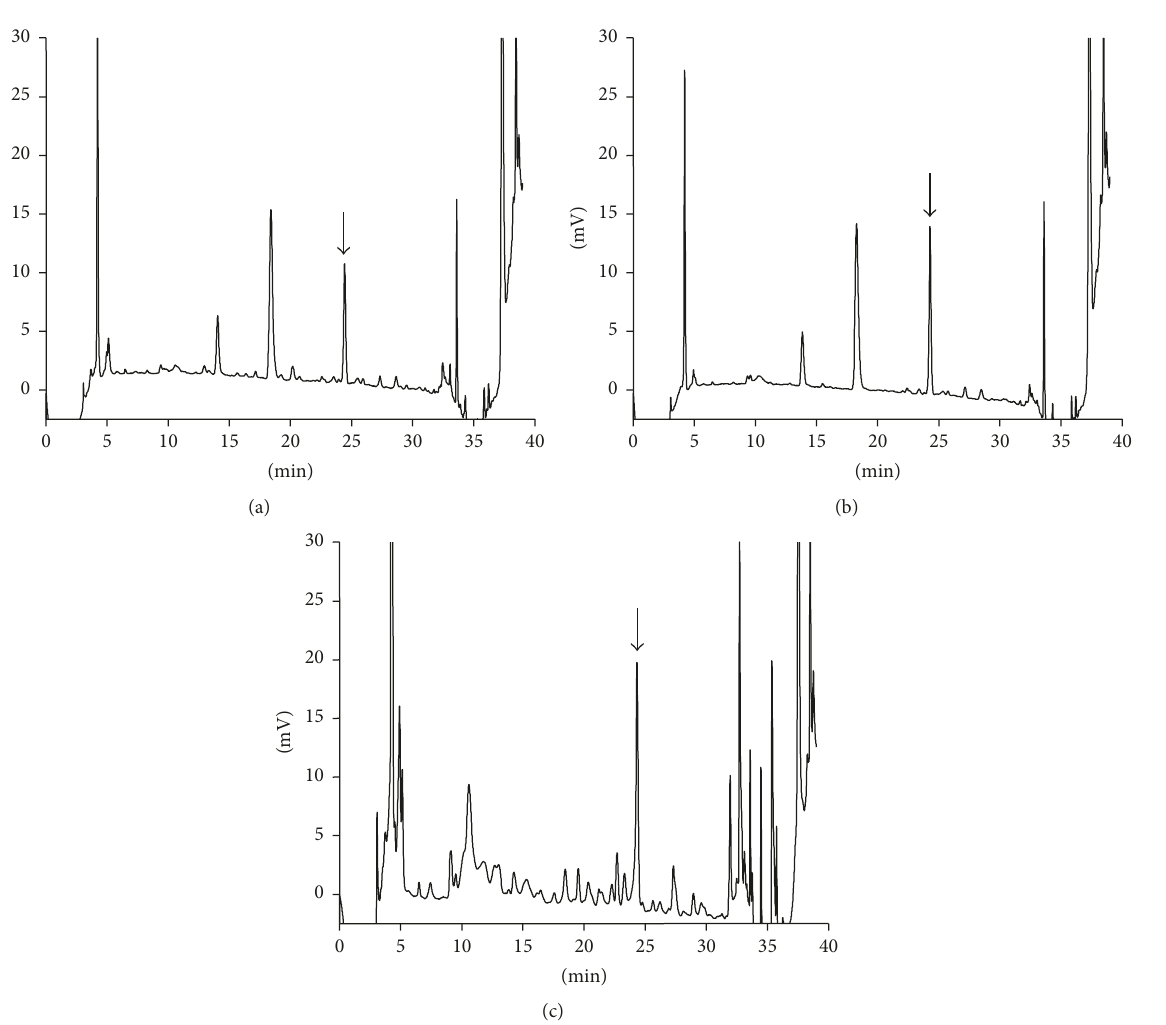
Figure 3: Chromatograms after deproteinization of a human plasma blank (5.60 nM) (a), plasma standard spiked with 1nM of pentosidine (b), and a type 2 diabetes mellitus (T2DM) patient’s plasma (13.9nM) (c). The arrows show the pentosidine peak. The human plasma used in (a) and (b) was purchased from BioChemed Services.